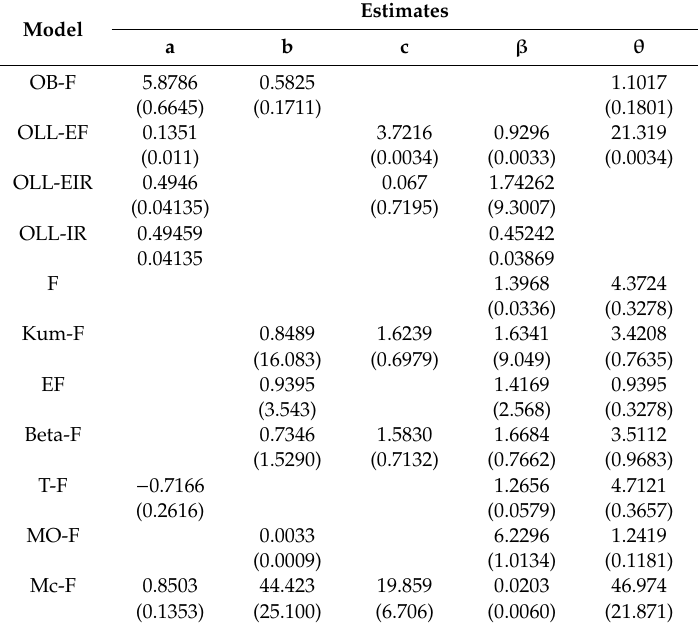
Table 8. MLEs and their standard errors (in parentheses) for data set I.